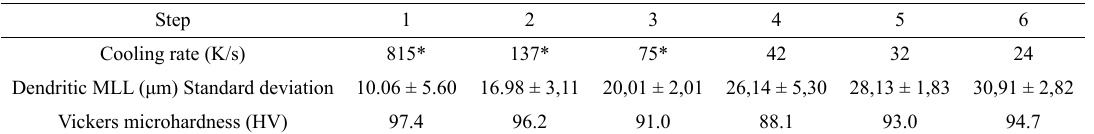
Table 4. Cooling rates in semi-solid region estimated by cooling curve, mean linear length (MLL) of dendritic and Vickers microhardness (HV) of Al-5Si3Cu solidified in six-stepped cylindrical steel mold. (*) cooling rates calculate by Chvorinov's rule 1 . Step 1